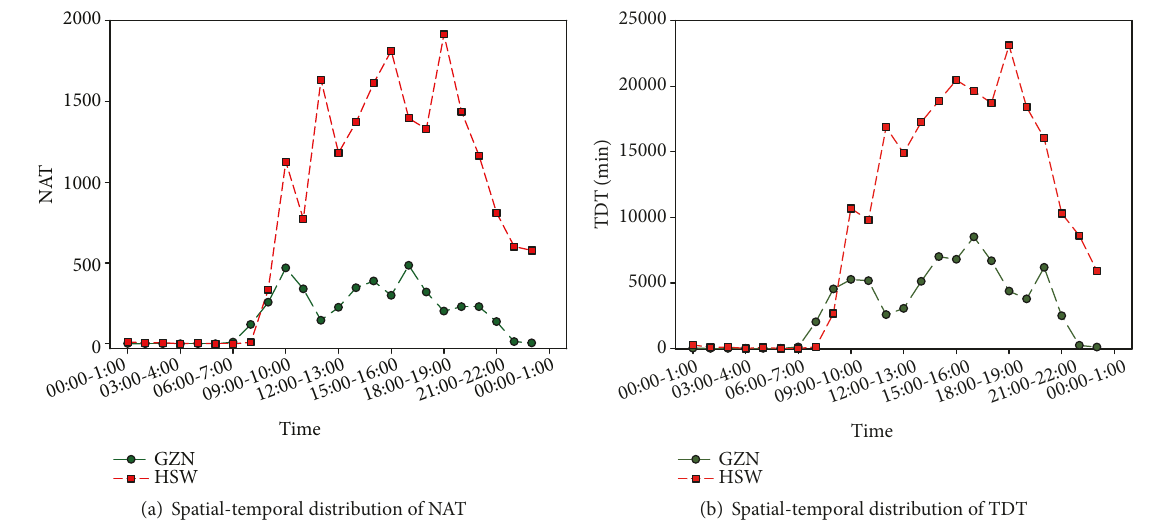
Figure 3: Spatial-temporal distribution of NAT and TDT for W-G